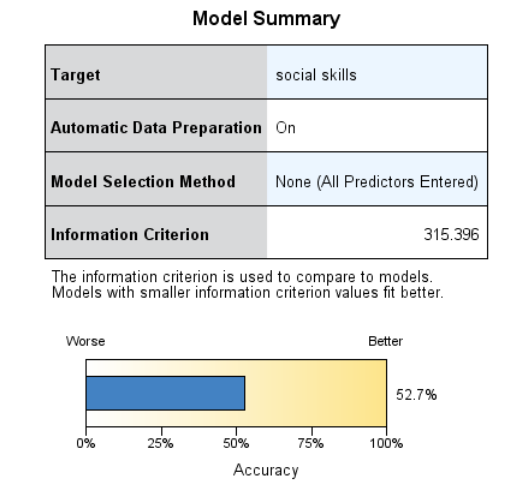
Figure 4. Social skills performance (source: created by